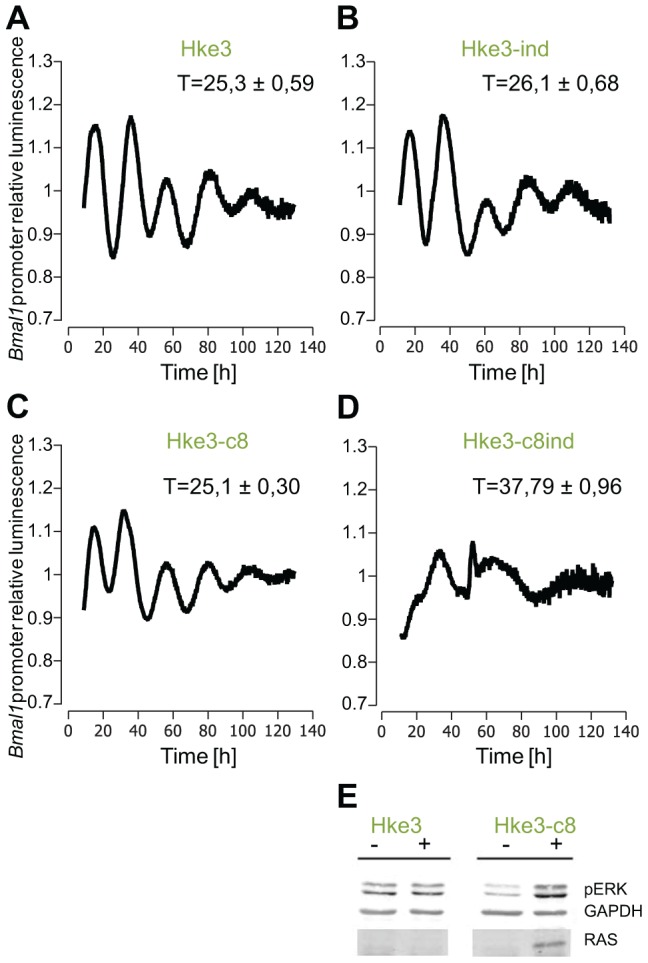
Effect of KRAS induction in HKe3 and HKe3 clone 8 cell lines.Shown are the results from 3 independent experiments. (A) HKe3 have a period of 25.3±0.59 hours (p<0.05, Student's t-test), (B) HKe3 cells treated with mifepristone show a small period increase (26.1±0.68 hours p<0.05, Student's t-test). (C) HKe3 clone8 present a period of 25.1±0.3 hours (p<0.05, Student's t-test). (D) HKe3 clone8 cells treated with mifepristone show a large period increase (37.79±0.96 hours p<0.05, Student's t-test). (E) Western Blot analysis for RAS and phosphorylated ERK in HKe3 and HKe3 clone8 cells following K-Ras induction by mifepristone. Extracts where prepared from untreated cells (−) or 48 hours after addition of mifepristone (+). Levels of RAS and phosphorylated ERK were analysed. GAPDH was used as loading control.